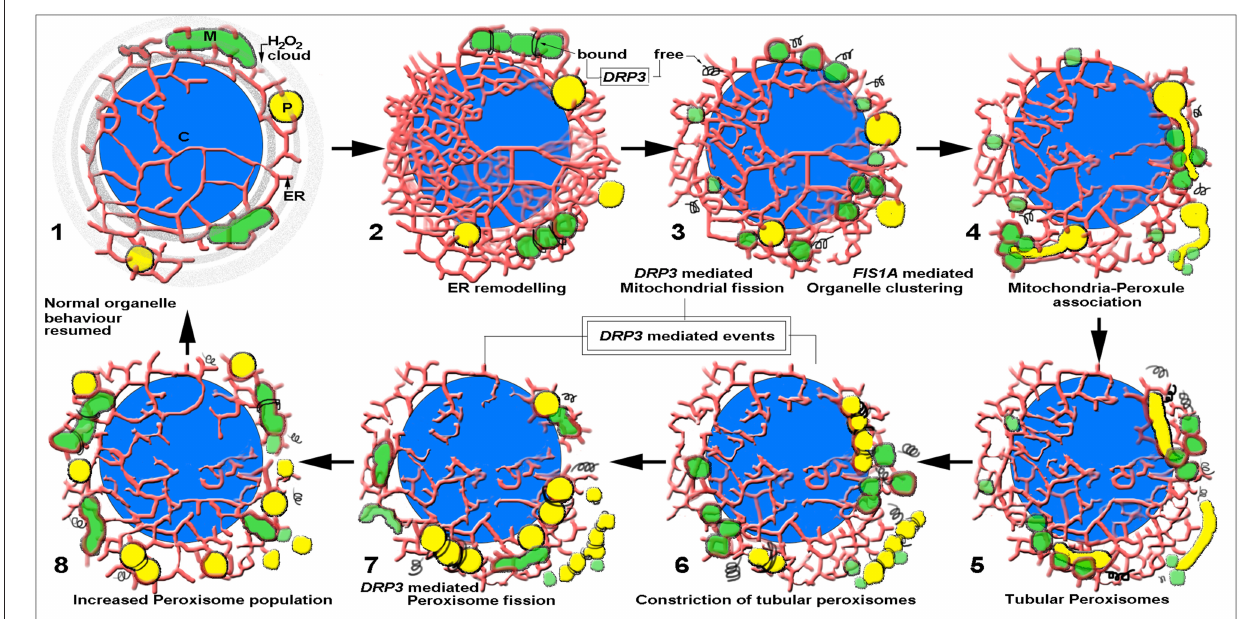
FIGURE 4 | A speculative diagrammatic depiction of the sequence of responses and interactions involving chloroplasts (C), endoplasmic reticulum (ER), mitochondria (M) and peroxisomes (P) following transient high-light (HL) induced ROS stress. 1. A chloroplast acts as a focal point for H 2 O 2 release into the cell. Neighboring membranes and organelles are affected before the H 2 O 2 -cloud dissipates and gets neutralized. 2. ER polygons and cisternae around a chloroplast are affected by the transient increase in H 2 O 2 and organize into an ER-chloroplast nexus that brings peroxisomes and mitochondria closer to the chloroplast. Mitochondria undergo fission rapidly in a DRP3 (shown as spirals) aided manner in response to increased H 2 O 2 /ROS. 3. The ER-chloroplast nexus disassembles but FIS1A present on chloroplast, mitochondrial and peroxisomal membranes tethers the organelles together and promotes their interactions. Note that the cytosolic concentration of free-DRP3 is speculated to increase after mitochondrial fission. 4. Small mitochondria cluster around thin dynamic peroxules extended by spherical peroxisomes. The sustained proximity might aid both non-vesicular and vesicular interactions between the organelles as well as promote the redistribution of DRP3 proteins. 5. Spherical peroxisomes are molded into tubules of nearly uniform diameter similar to that of tubular mitochondria. 6. Tubular peroxisomes become beaded as DRP3 binds and constricts at regular intervals. 7. Beaded peroxisomes undergo fission at DRP3-constricted sites through ER-aided contortions. 8. The peroxisomal population in the cell increases and aids rapid scavenging of H 2 O 2 /ROS to basal levels. Mitochondria resume their normal ER-mediated fusion-fission behavior. Normalcy is restored within the cell and the increased peroxisomal population fortifies the cell temporarily against harsher ROS